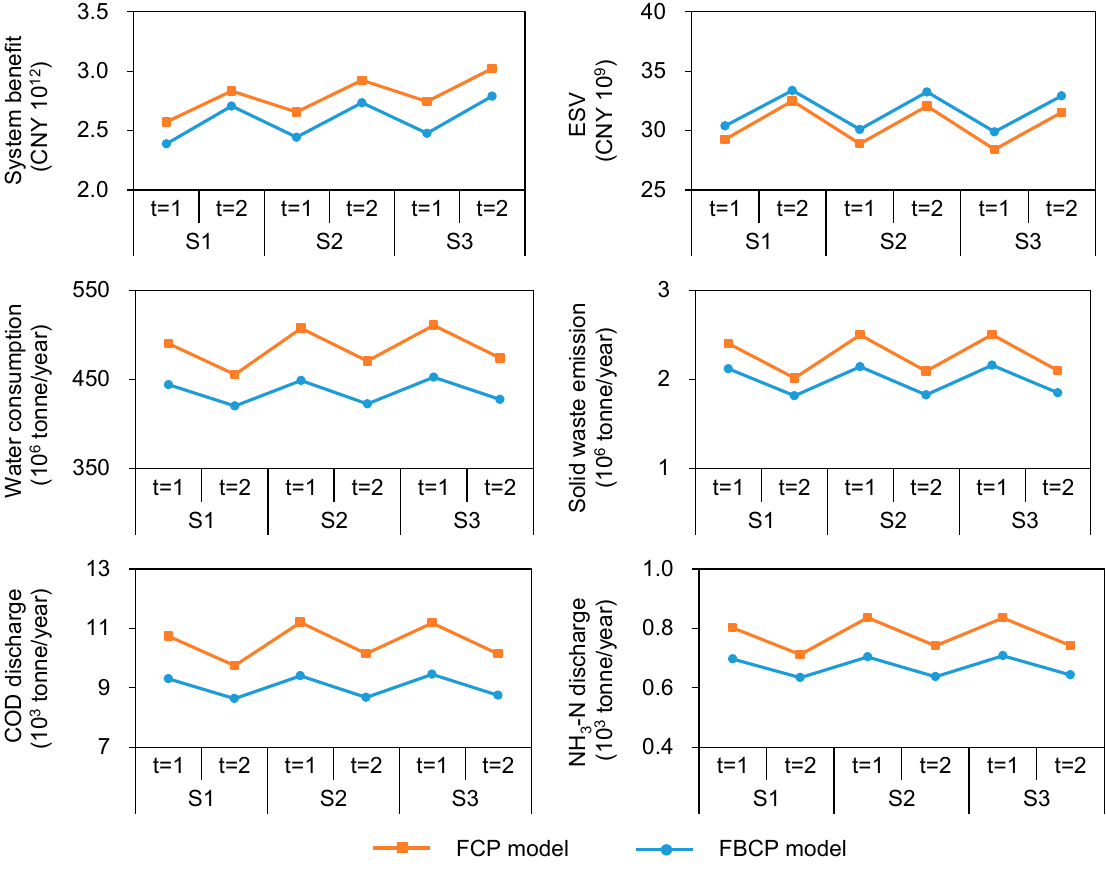
Figure 11. Comparison of FCP and FBCP model.